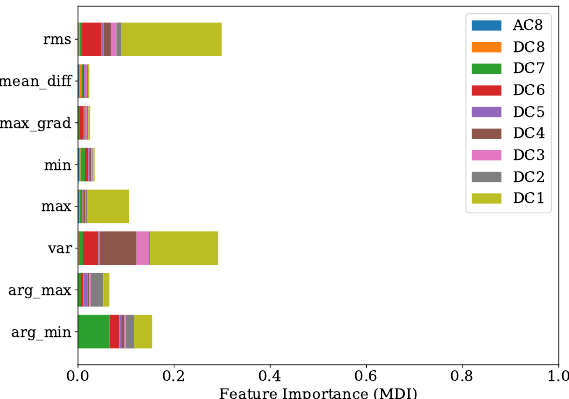
Figure 17. FI of PFP regression with regard to training set of engine